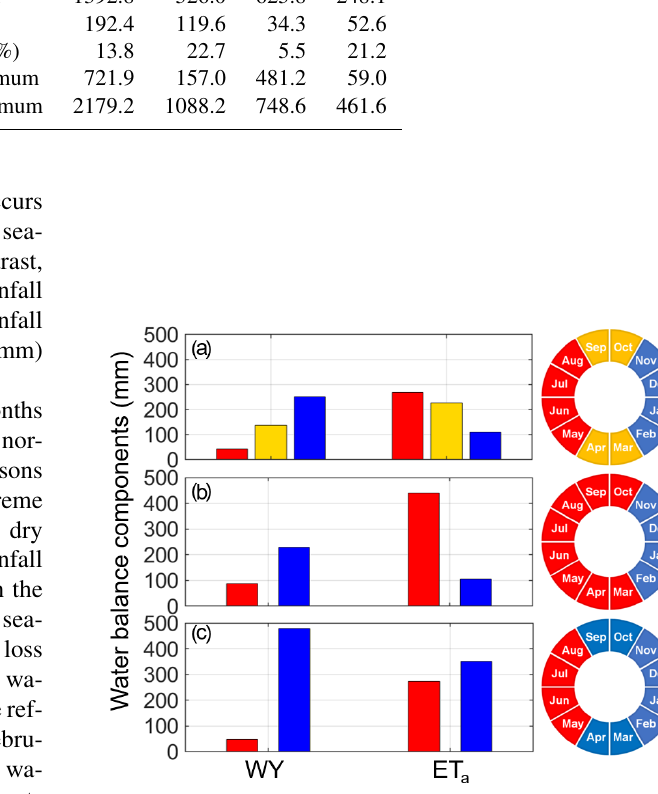
Figure 11. Main water balance components in the static approach, namely seasonal water yield (WY) and actual evapotranspiration (ET a ) in the dry (red bars), transition (orange bars), and wet seasons (blue bars). Three scenarios are presented: (a) reference scenario with the dry, transition, and wet seasons all lasting 4 months; (b) dry scenario with the dry and wet seasons lasting 8 and 4 months, re- spectively; and (c) wet scenario with the dry and wet seasons lasting 4 and 8 months,